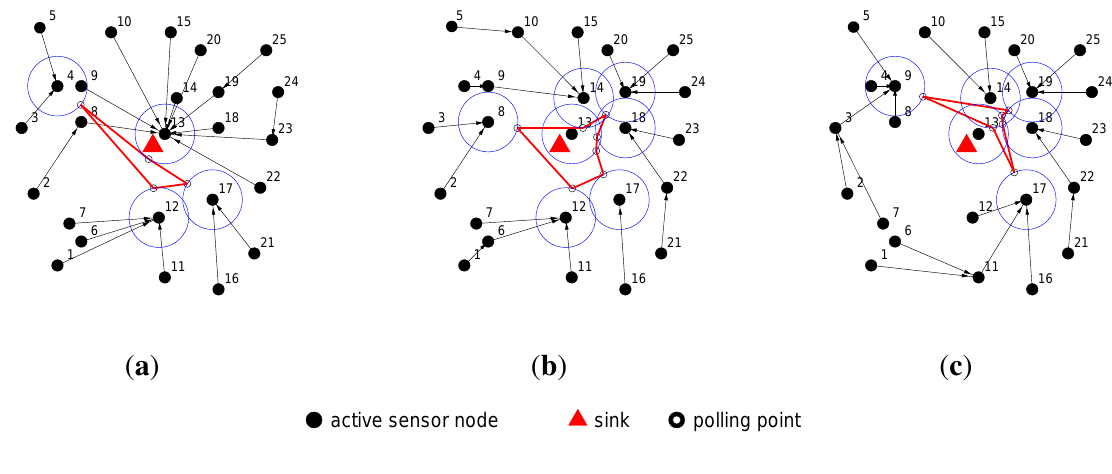
In Figure 3, the moving path of the actuator is highlighted by the red line, and the blue circles indicate the communication range of the polling points. This group of figures shows that after several rounds, as , v ) change, the shortest path tree is reconstructed and the moving path the C values of every edge ( v ij i j of the actuator is also changed. Figure 3. The dynamic moving path planning of IPA. The edges of the red polygons represent the moving path of the mobile actuator, and the blue circles represent the communication range of the polling points. IPA periodically reconstructs the shortest path tree and then re-selects the polling points before dynamically adjusting the path planning of the